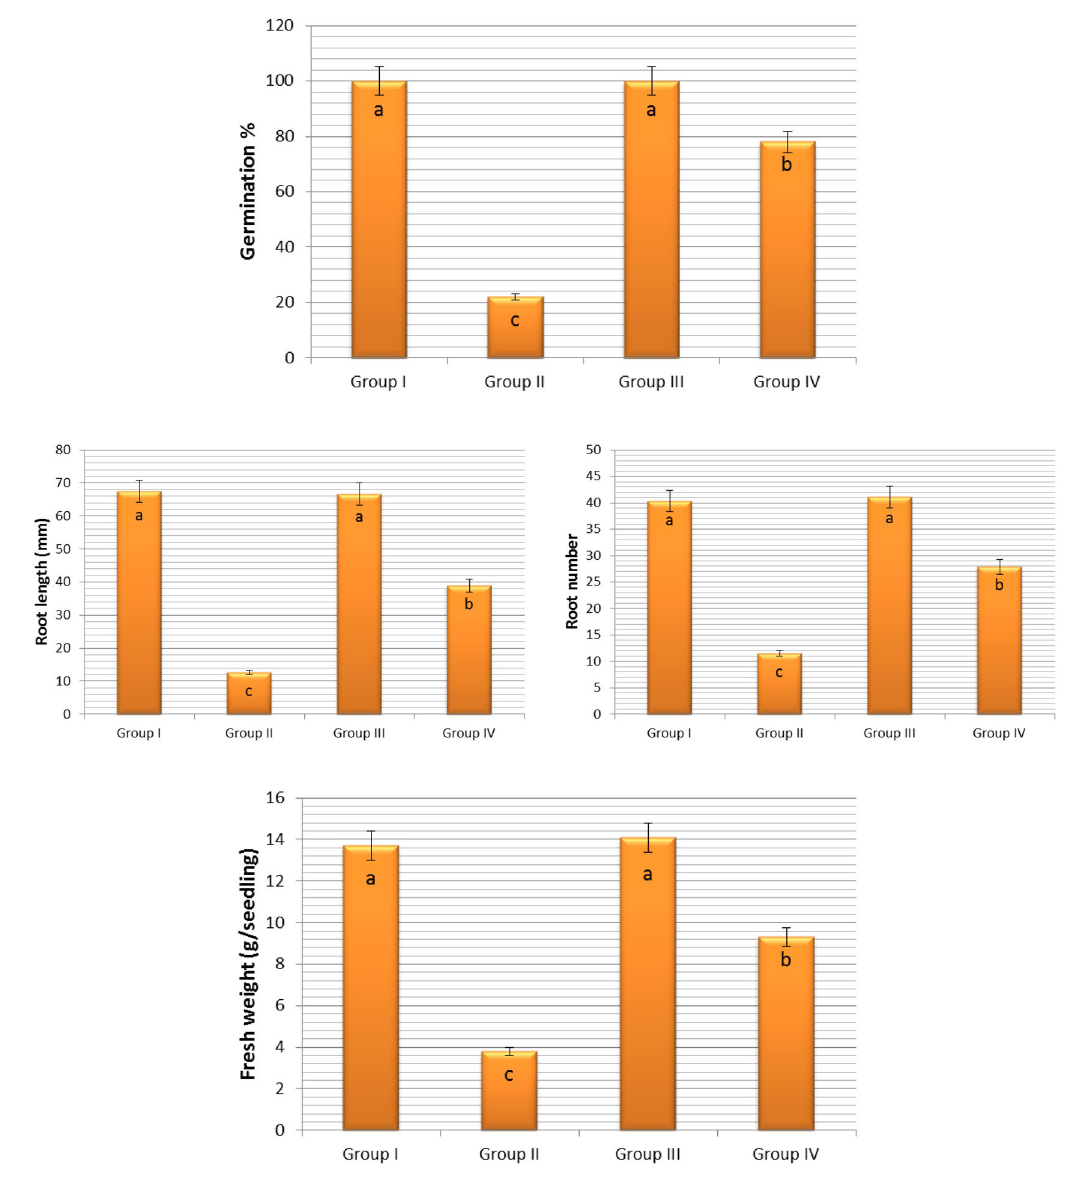
Figure 1. Effect of COR on some physiological parameters of Allium cepa L. Group I (control) was treated with tap water; Group II was treated with 0.15 M NaCl; Group III was treated with 0.01 µM COR; Group IV was treated with 0.01 µM COR + 0.15 M NaCl. The error bars indicate the standard deviation (±